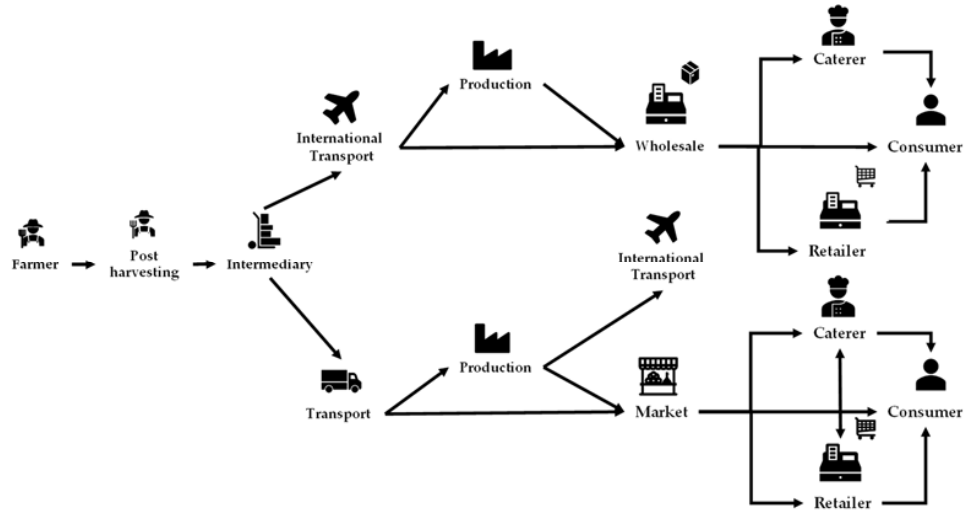
Figure 2. Functional areas and actors in international food value chains, own representation based on [16,17,22].